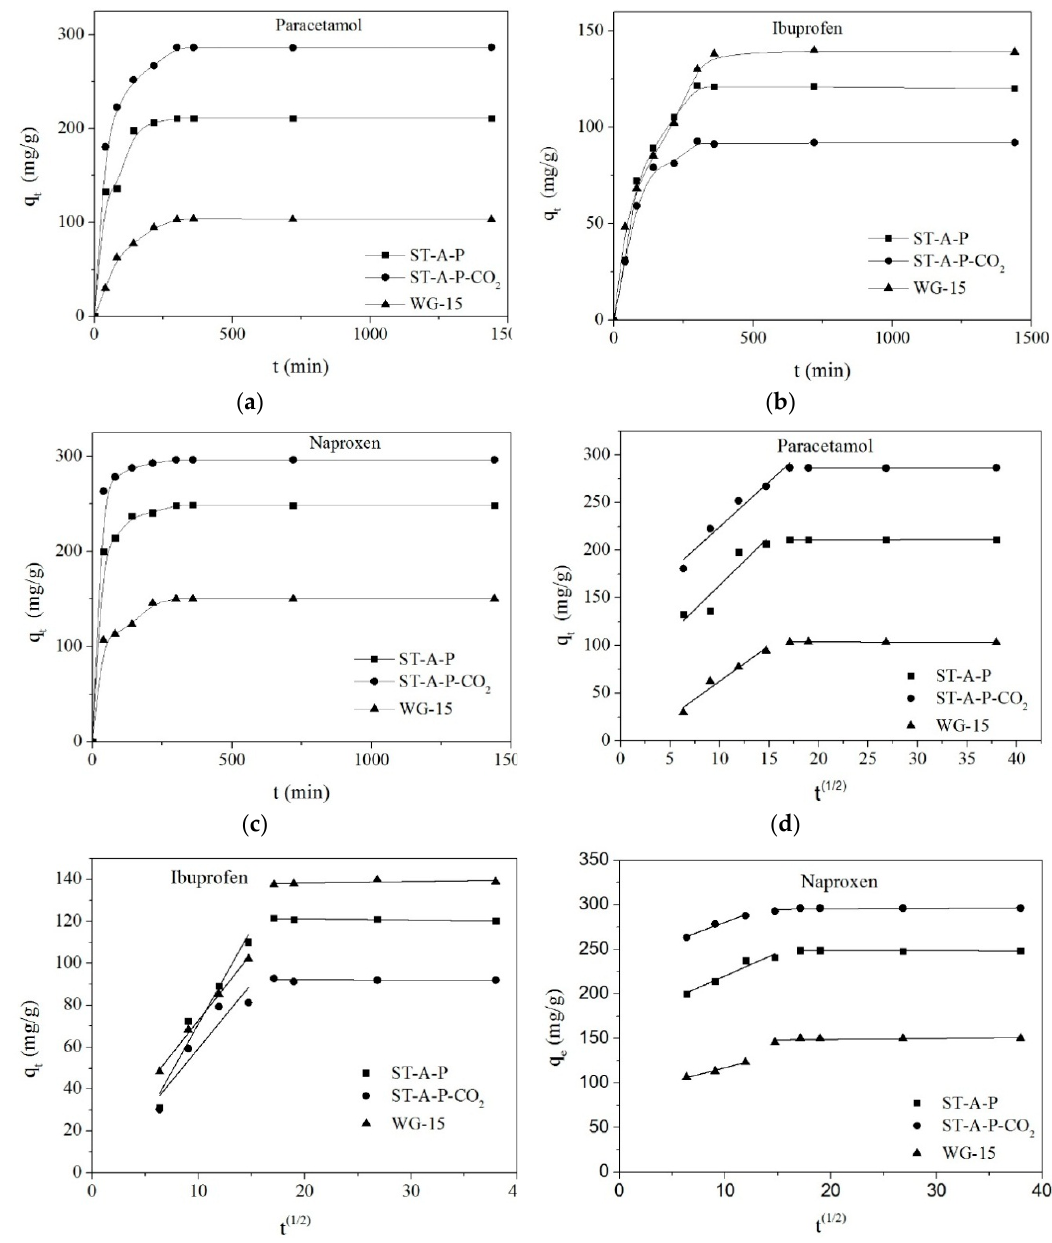
Figure 6. Kinetic adsorption curves ( a – c ), C o 300 mg dm − 3 and the intra-particle diffusion ( d – f ) of paracetamol and NSAIDs on carbon materials studied. Table 5. Kinetic parameters of paracetamol and NSAIDs adsorption on the studied adsorbents.